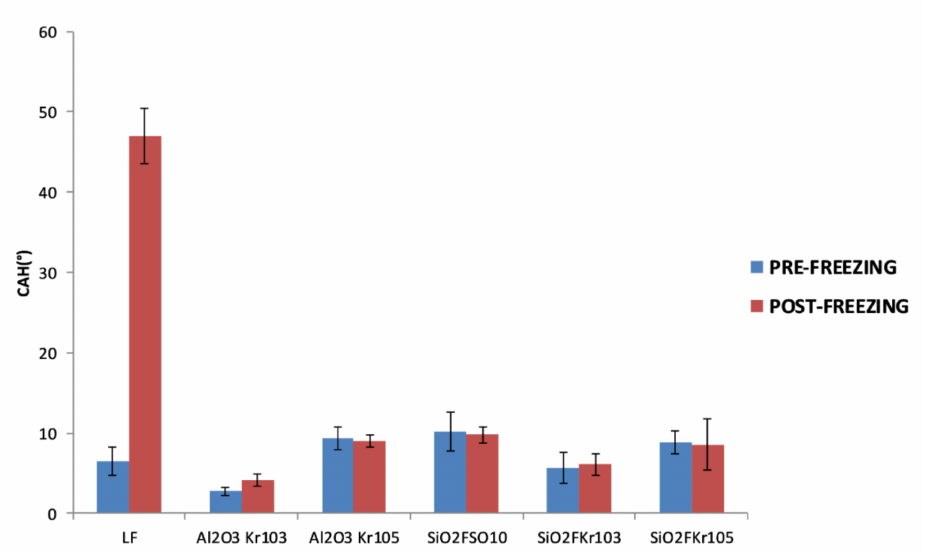
Figure 8. Average values of contact angle hysteresis (CAH) for selected coated samples before (blue) and after a single freeze/thaw cycle (red). Standard deviations are reported as errors